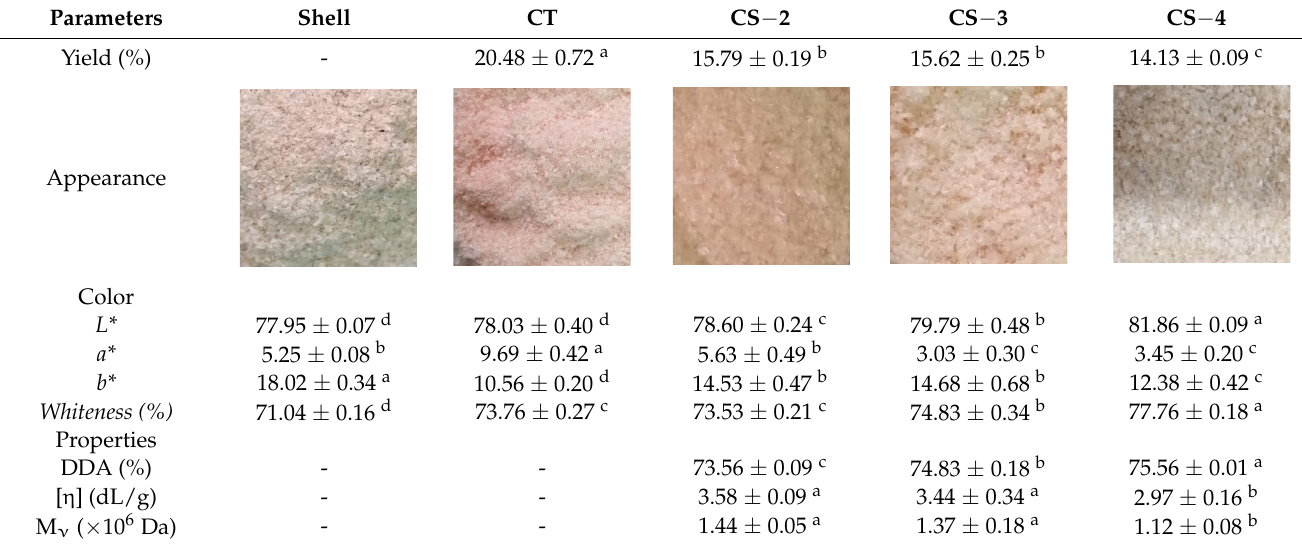
Table 1. Yield, color and physico–chemical properties of mantis shrimp ( Oratosquilla nepa ) shell, CT and CS obtained by different deacetylation times.